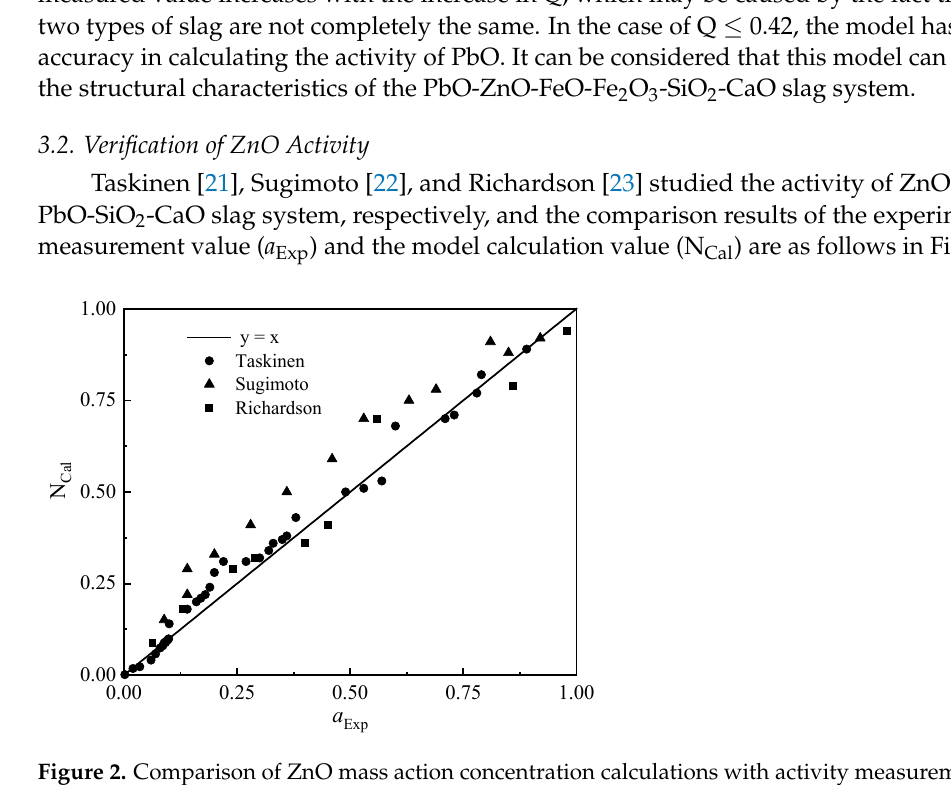
Figure 1. Calculated and measured activity values of PbO.